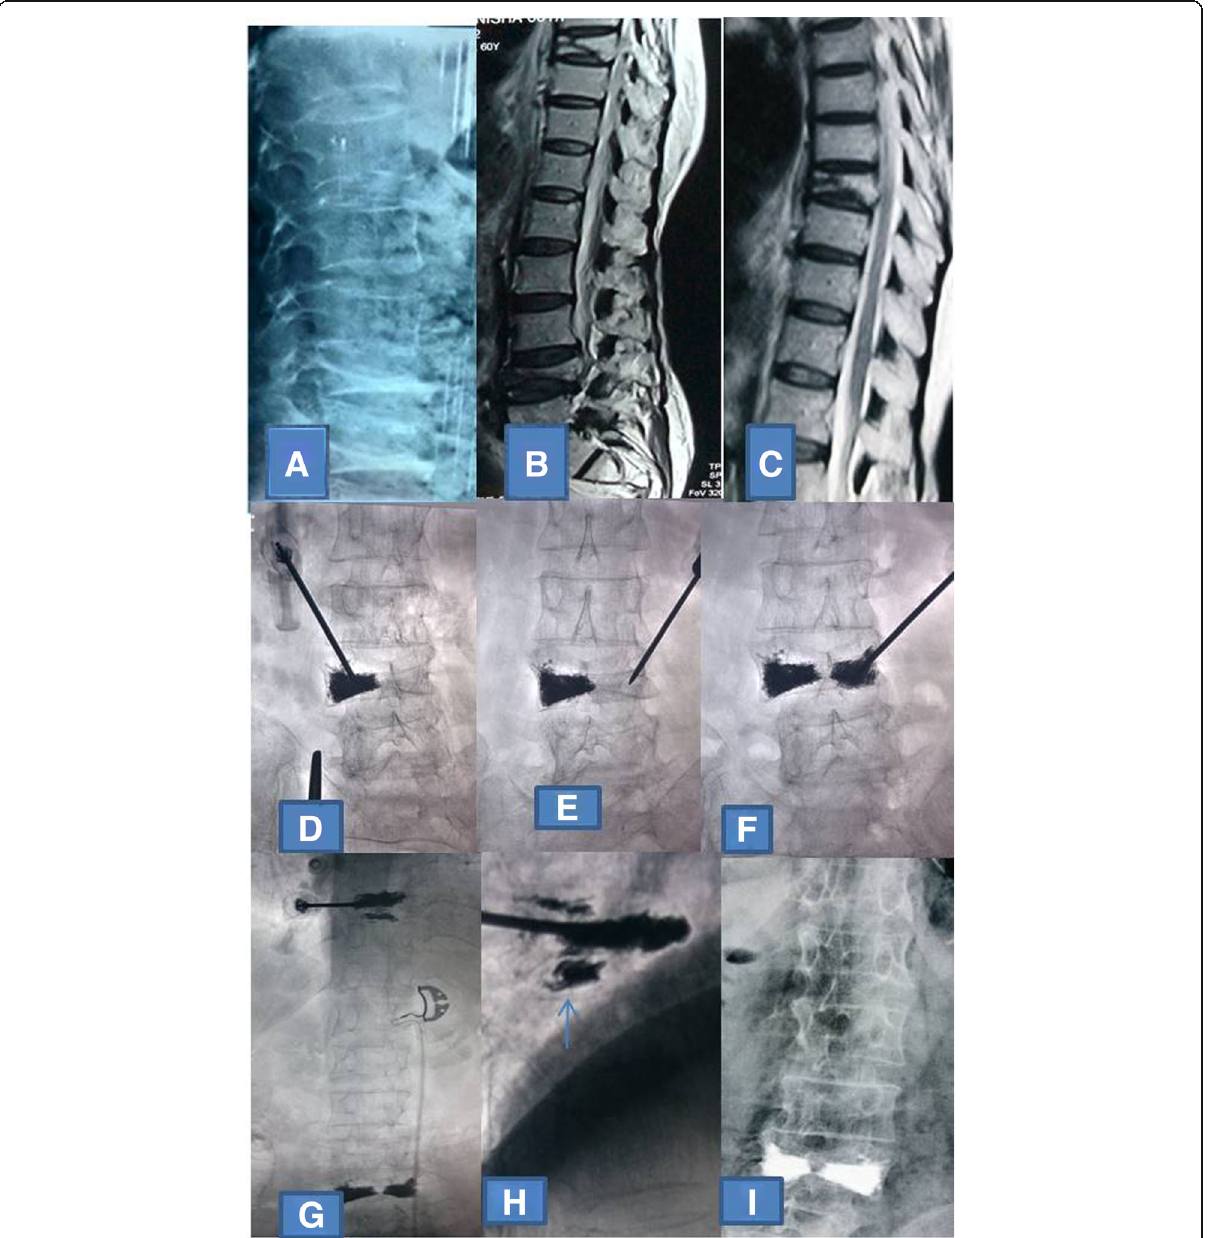
Fig. 4 A 50-year-old female with history of back ache pain since last one month. a X-ray lateral view lumbar vertebrae showing L4 osteoporotic collapse. b , c MRI T1 AND T2WI shows osteoporotic collapse of D9 and L4 vertebral body, with adjacent bone marrow edema. d – f DSA images showing bipedicular approach of cement injection in L4 vertebrae. g , h DSA images showing unipedicular cement injection in D9 vertebral body, magnified image of D9 vertebra showing extension of cement in adjacent intervertebral disc space(arrow). i Post-vertebroplasty X-ray image shows adequate filling of bone cement in the body of L4 vertebra. There was extension of cement mixture in to D9 – D10 IV disc space. However, patient had no clinical symptoms of sensori-motor radiculopathy. Patient had significant relief in pain on 3-month